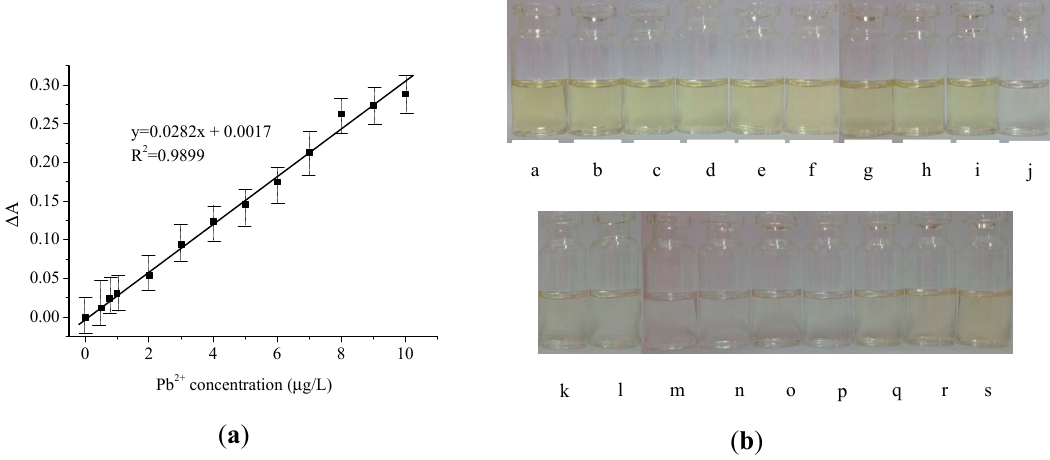
Figure 4. ( a ) Calibration curve of colorimetric sensing of Pb 2 + in the concentration range of 0–10.0 µ g / L, ( b ) Color of the AgNPs colloid with Pb 2 + concentration of (a) 0, (b) 0.500, (c) 0.750, (d) 1.00, (e) 2.00, (f) 3.00, (g) 4.00, (h) 5.00, (i) 6.00, (j) 7.00, (k) 10.0, (l) 25.0, (m) 50.0, (n) 75.0, (o) 100, (p) 250, (q) 500, (r) 750, and (s) 1000 µ g / L.